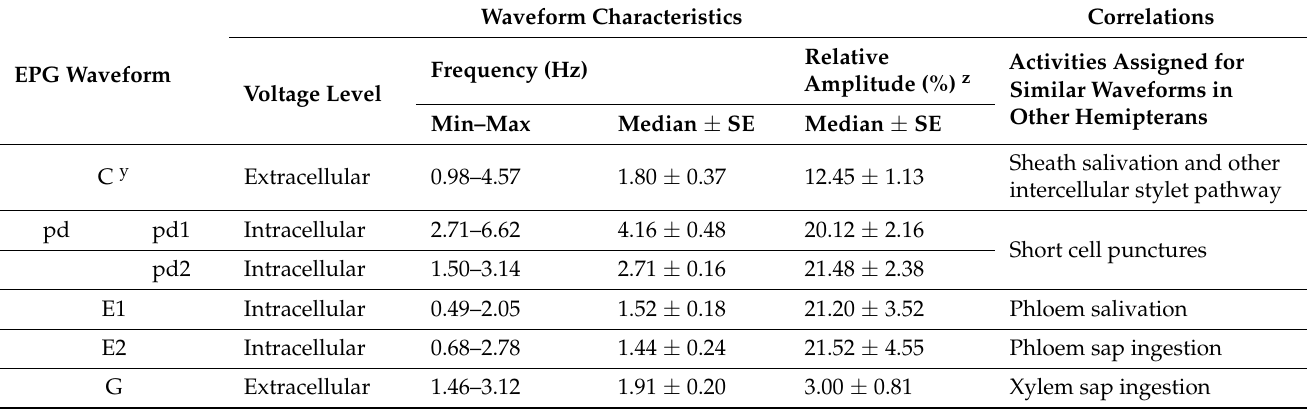
Table 2. Characteristics of the EPG waveforms recorded during Acanthococcus lagerstroemiae probing on Lagerstroemia limii